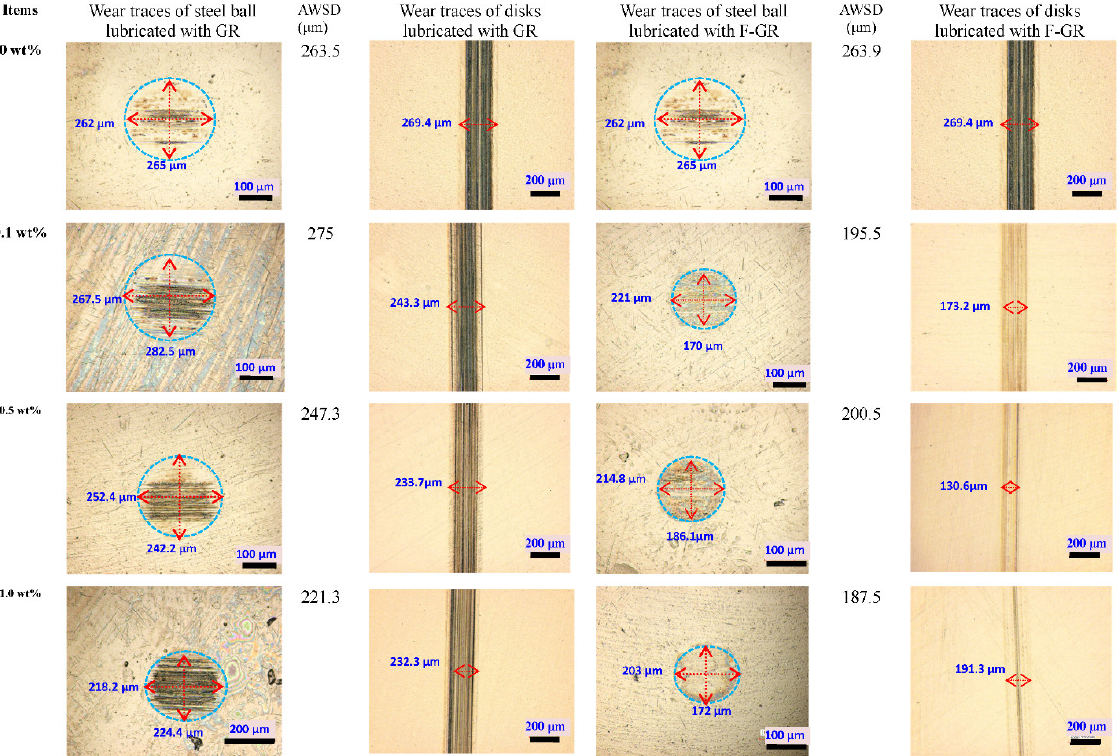
Figure 6. Optical morphologies of wear traces on the surfaces of steel balls and disks lubricated with different oil samples at 50 N and 10 mm/s for 60 min.